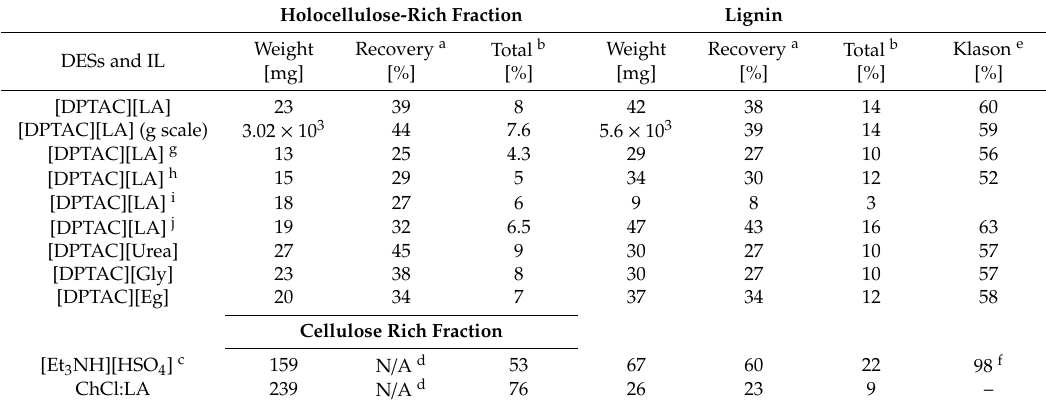
Table 3. Results of the lignin extraction and holocellulose recovery from olive pomace using DESs and IL. DESs and IL